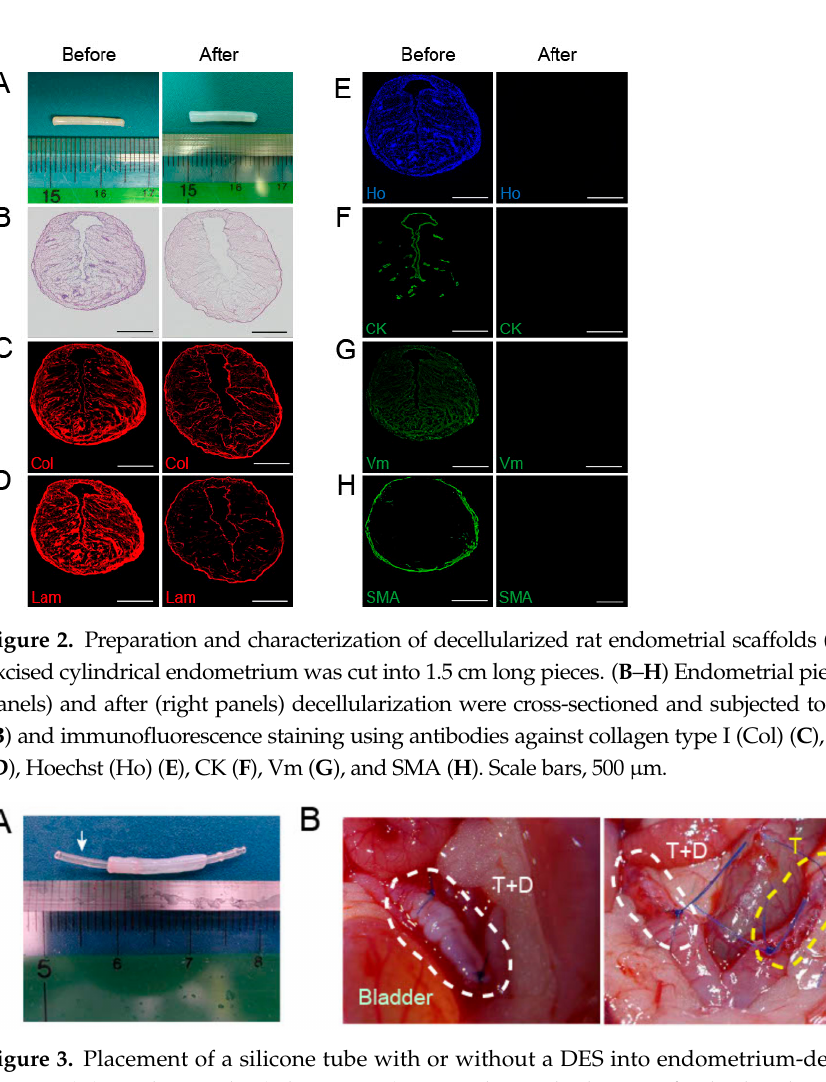
(T) or tube-loaded DES (T+D) was placed into the endometrium-defective site of each uterine horn (circled by white and yellow dotted lines, respectively). The muscle layer and serosa were continu- ously sutured.